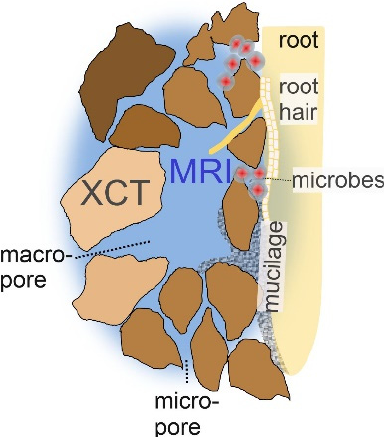
Figure 1. Sketch of the pore system and the domains addressed by different non-invasive imaging methods. X-ray computed microtomography (XCT) is sensitive to the solid soil structure and magnetic resonance imaging (MRI) is sensitive to the fluid in the pore system and its dynamics. The NMR principle is that certain atomic nuclei possess a quantum-mechanical prop- erty called spin, which is linked to a nuclear magnetic moment and interacts with the external magnetic field B 0 . Many spins form an ensemble with a macroscopic magnetiza- tion aligned with the direction of B 0 in equilibrium. This equilibrium can be disturbed by the application of a radio frequency pulse if its frequency matches the Larmor-frequency of the spin system, ν 0 = γ B 0 /2 π , where γ is the gyromagnetic ratio of the nucleus under consideration. It is, in most cases, the hydrogen atom 1 H, which is abundant in water or hydrocarbons. After excitation, the nuclear magnetization induces a current in the surrounding rf coil, which produces the NMR-signal. Further excitation pulses, frequently combined with magnetic field gradient pulses can modify the signal—for instance, to create one or more echoes. In parallel, the equilibrium is re-established by characteristic relaxation processes, denoted as T 1 and T 2 relaxation, sensitive to the physical and chem- ical environments. The observable signal relies on the interplay between magnetic and dynamic (rotational and translational diffusion, flow) properties of the actual system and method-specific, adjustable parameters. The spatial coordinates of an image are encoded in MRI by switching additional magnetic field gradients before or during signal acquisition. The sequential application of all pulses is termed the MRI pulse sequence. Eventually, Fourier transformation of a time series of NMR signals obtained with systematic variation of the pulsed magnetic field gradients yields the 2D or 3D image. The versatility of the information of MRI is due to the fact that the signal intensity of the individual image pixels, i.e., the contrast, is controlled by factors such as the volumetric water content, the NMR relaxation times T 1 and T 2 , diffusion coefficients, and flow velocity, which allows tuning the MRI pulse sequence to be sensitive to certain of these parameters. For